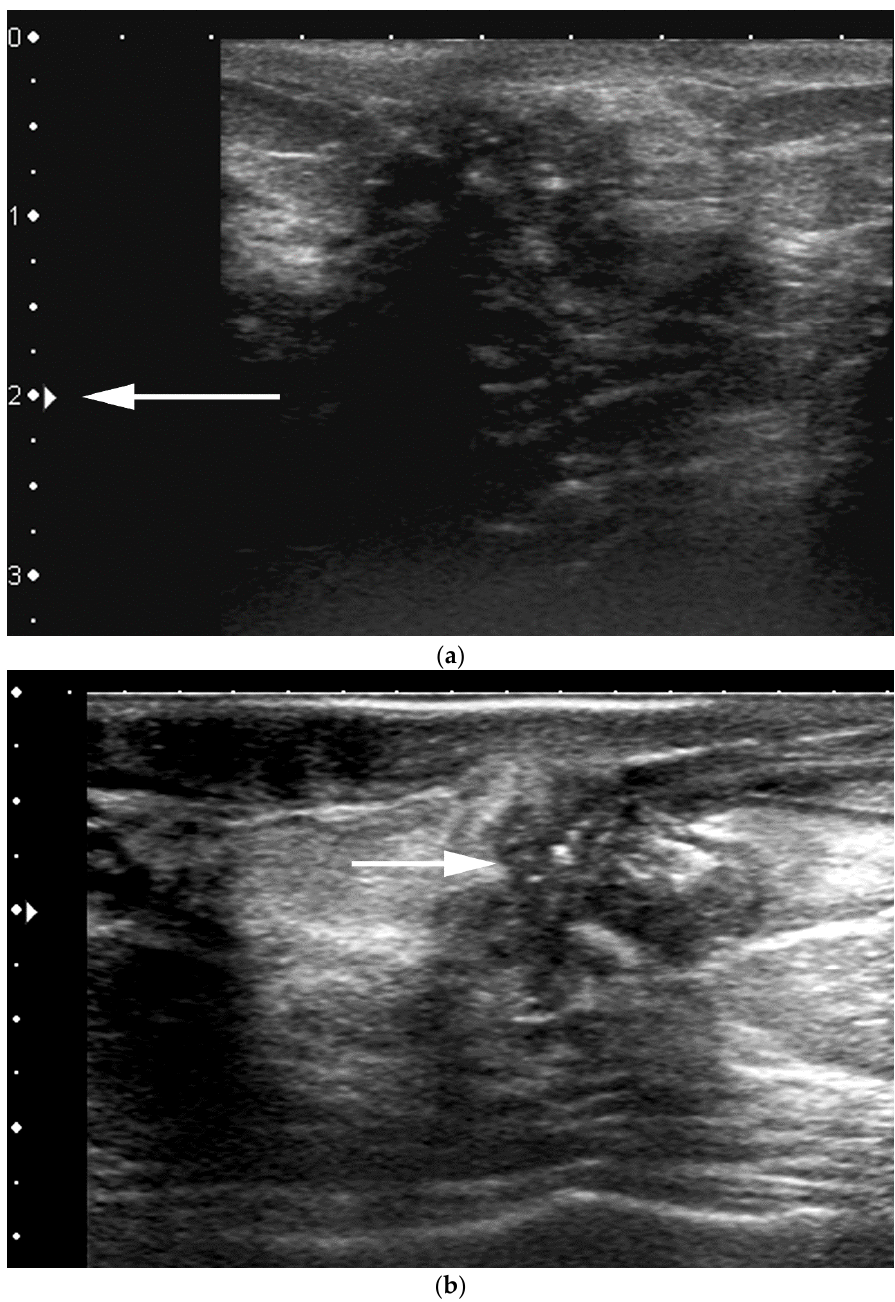
Figure 8. US images of a suspicious retroareolar mass in 64-year-old patient. Focal position is not accurate ( a ) (arrow). An optimal focal adjustement ( b ) allows an improved visualization of the suspicious mass. US-guided core needle demonstrated an invasive ductal carcinoma.